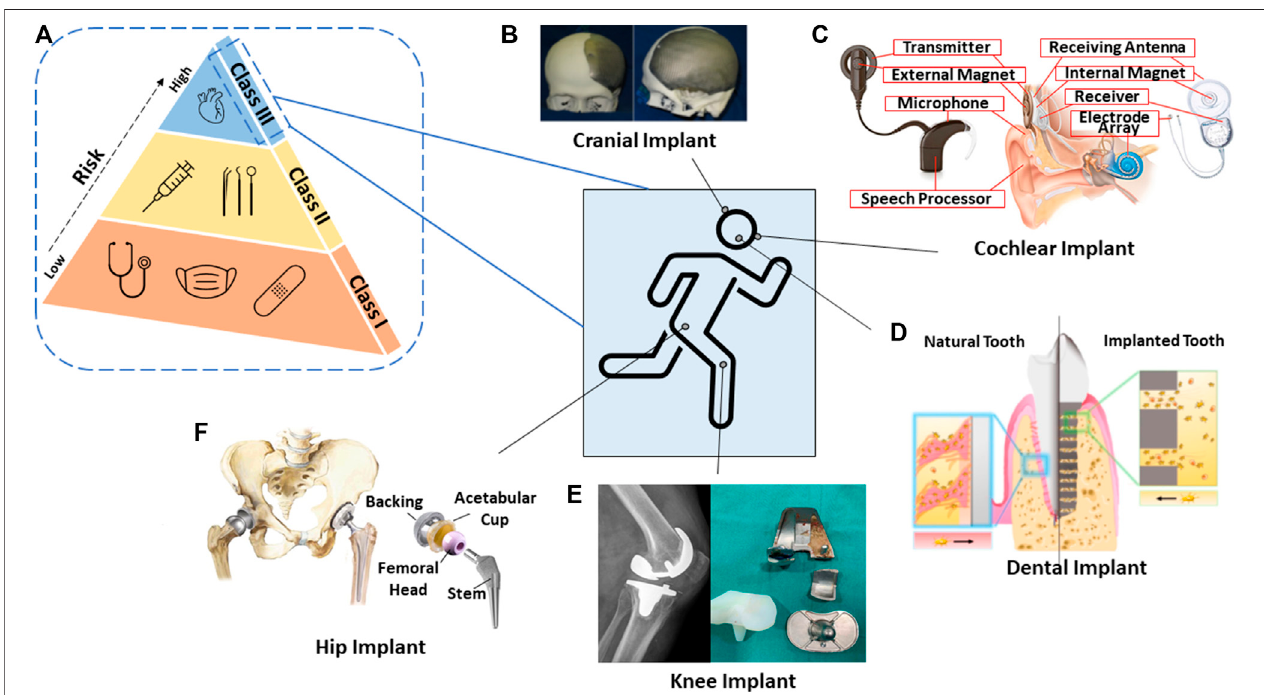
FIGURE 1 | Schematic diagram of the (A) risk associated within FDA-classi fi ed medical devices; and some graphics of 3D-printed biomedical applications in the human body system. (B) Cranialimplant (Jardini et al., 2016). (C) Cochlear implant (Brand et al., 2014). (D) Dental implant (Yin et al., 2021). (E) Knee implant (Chithartha et al., 2020). (F) Hip implant (Mattei et al.,